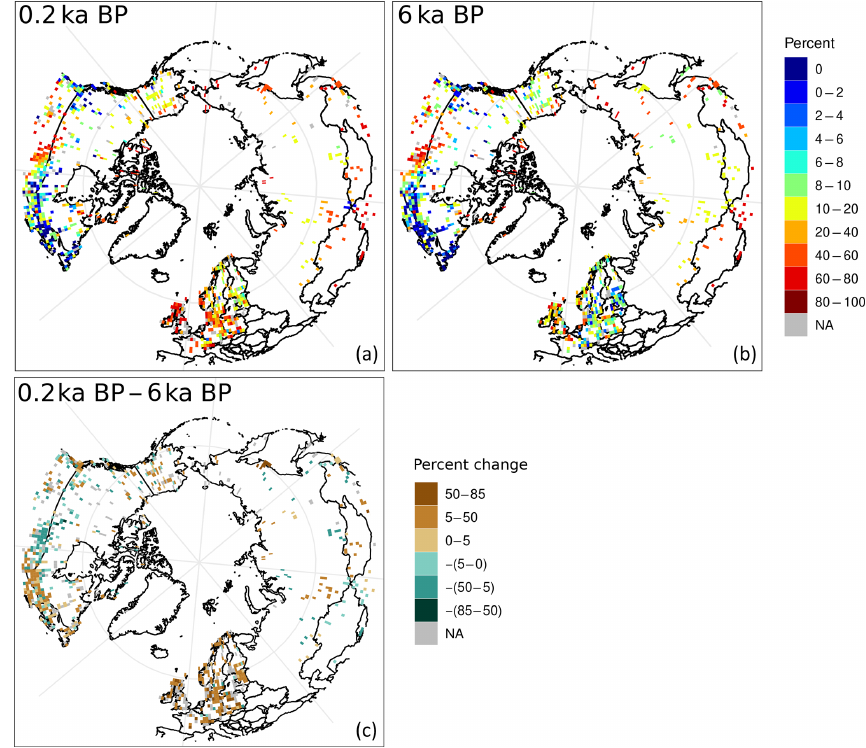
Figure 7. Northern extratropical ( > 40 ◦ N) mean fractional cover of open land at 6000 years ago (6kaBP: b ) and 200 years ago (0.2kaBP: a ) estimated using REVEALS and the difference in fractional cover between the two periods (c) . Red indicates an increase in open land and blue a decrease (after Dawson et al.,